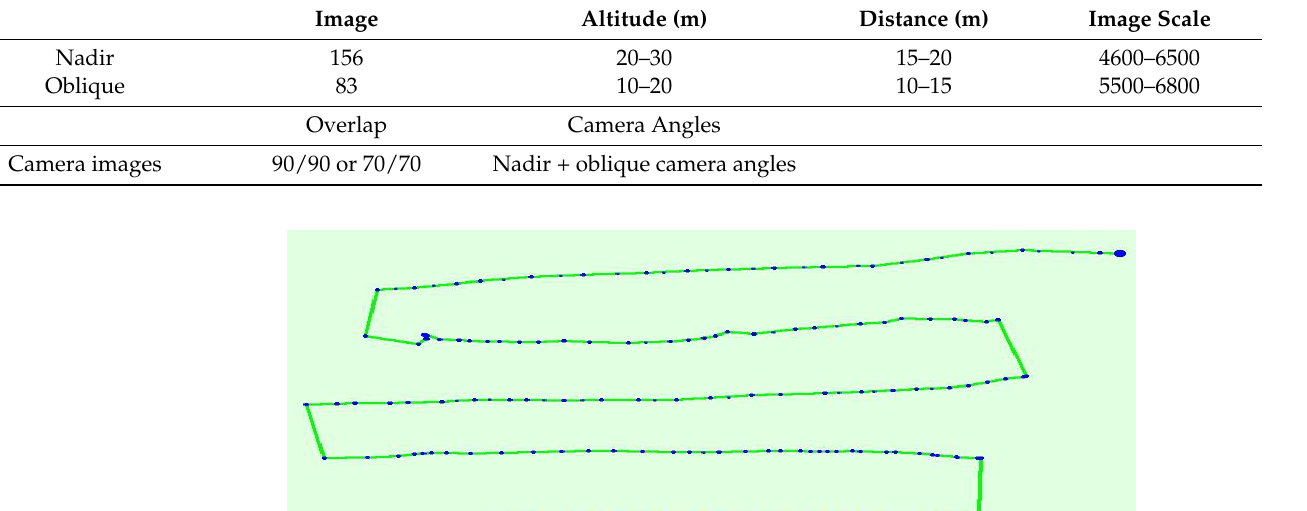
Figure 9. UAV flight route to gather oblique images. Lines represent the drone flight path; dots represent image capture positions on the flight path. The laser scan point cloud dataset was generated using a Leica laser scanner, which is capable of measuring at a long distance to capture the surface information of the object